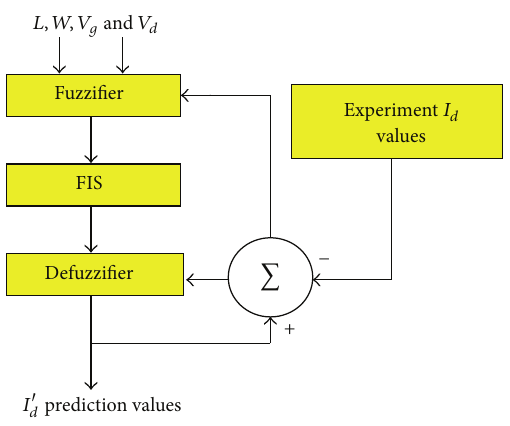
Figure 1: ANFIS training flow